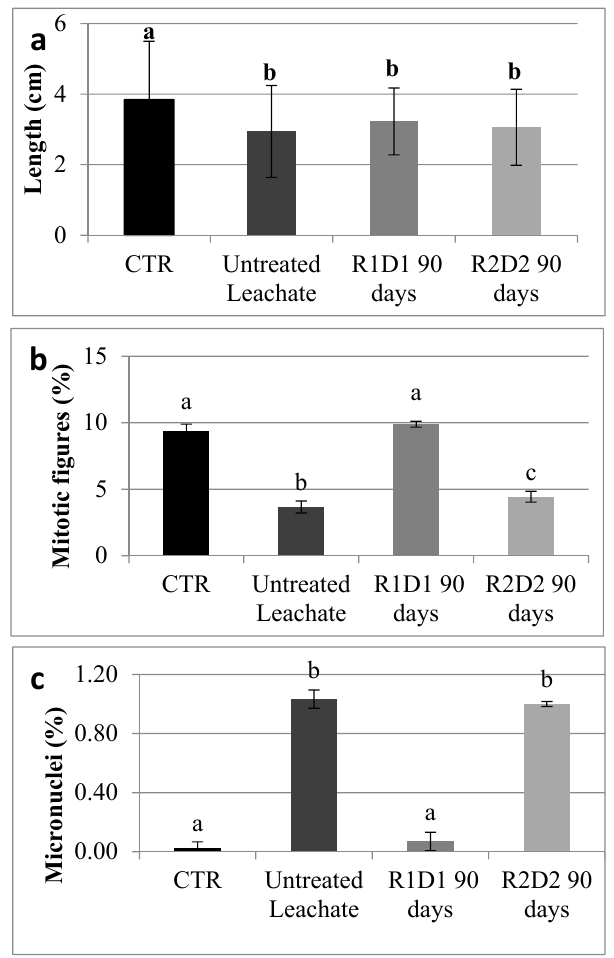
Figure 5. Panel ( a ) Phytotoxicity; ( b ) Cytotoxicity; ( c ) Genotoxicity of the intermediate Cuoio Depur WWTP intermediate leachate before and after the myco-based treatment. All the values are statistically di ff erent from the corresponding value at the untreated leachate (CTR) at the 1% ( p < 0.01). Bars represent the standard deviation (SD) among the three replicates of analysis. Statistically significant di ff erences of the data compared to the control (deionized water) are indicated by letters on the top of the bars.